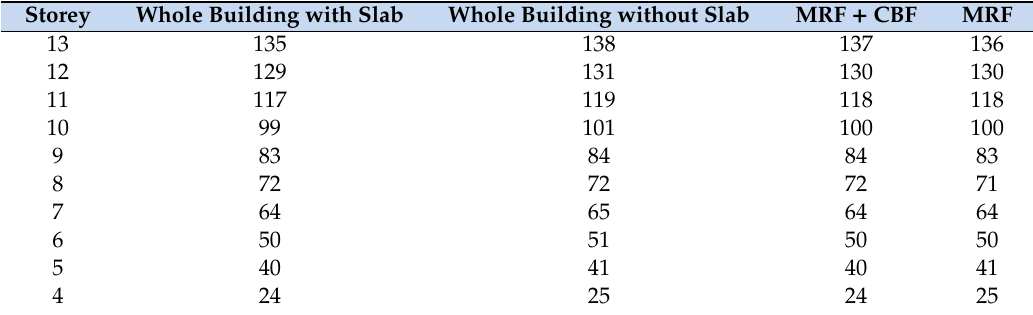
Table 3. Maximum lateral displacement during ULS earthquake for KHC & IHC